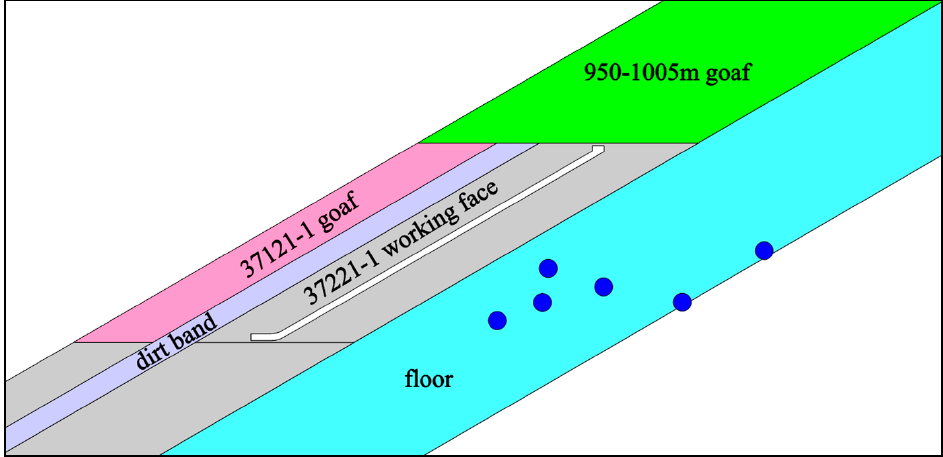
Figure 11. Projection diagram of mine earthquake cross section. Table 5. Deformation of roadway failure.